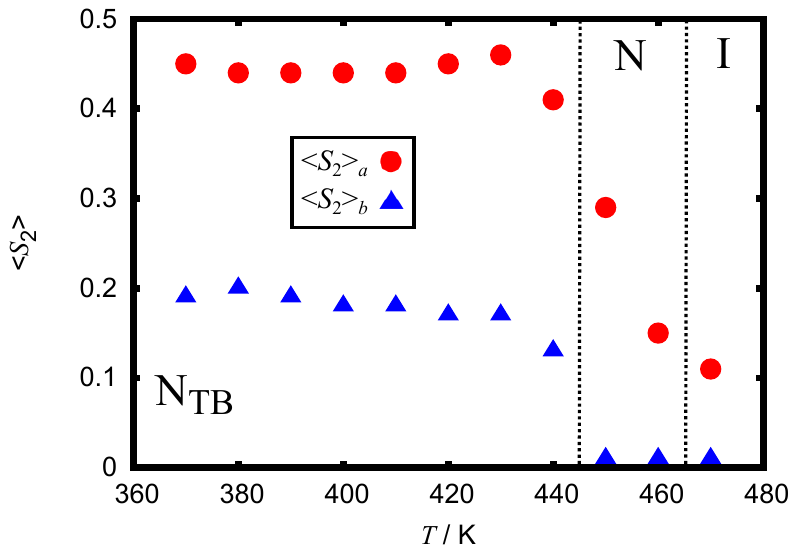
Figure 4. Temperature dependence of the orientational order parameter, (cid:104) S 2 (cid:105) , for unit vectors ˆ a and ˆ b for the FM CG